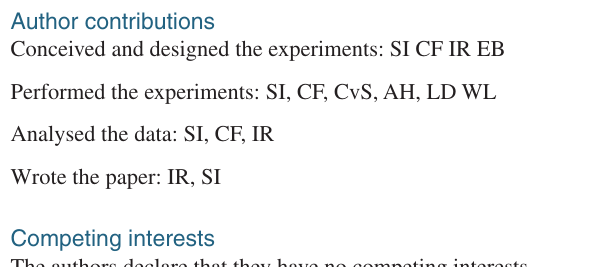
Figshare : Time-lapse imaging of wild-type trypanosomes express- ing histone 2B-GFP together with cytosolic GFP or DsRED. doi: 10.6084/m9.figshare.3126352.v1 83 Figshare : Time-lapse imaging of trypanosomes expressing cyto- plasmic GFP ( Δ proc) or calflagin-mCherry (WT). doi: 10.6084/ m9.figshare.3126355.v1 84 Figshare : Time-lapse imaging of trypanosomes expressing cyto- plasmic GFP ( Δ proc) or calflagin-mCherry (WT). doi: 10.6084/ m9.figshare.3126412.v1 85 Figshare : Time-lapse imaging of trypanosomes expressing cyto- plasmic GFP ( Δ proc) or calflagin-mCherry (WT). doi: 10.6084/ m9.figshare.3126415.v1